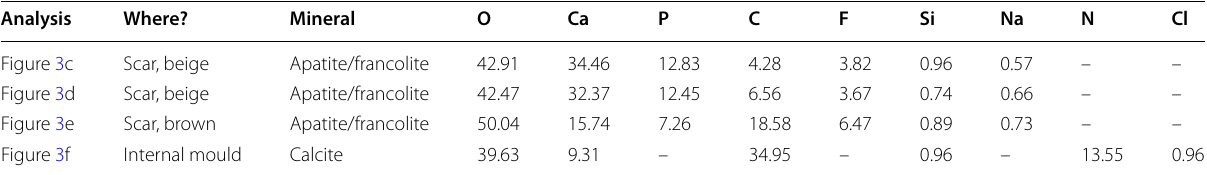
Table 2 Results of EDX-analyses in weight per cent carried out on and next to the remains of the right posterior adductor muscle of Acesta clypeiformis (PIMUZ 37855) Analysis Scar, beige Figure 3d Scar, beige Apatite/francolite Scar, brown Internal See Fig. 3 for the placement of the analyses R.R. took photos of the bivalve under white artificial light and a UVA-handlamp (Hönle UV technology) with a Nikon D3X with a Nikon AF-S Micro Nikkor 105 mm 1:2.8 objective and a UV (UV-Filter MC Lotus from Kai- ser Fototechnik) and polarising filters (Nikon Circular Polarizing Filter II). The colour of the UV-photos was corrected in Adobe PhotoShop 2021.